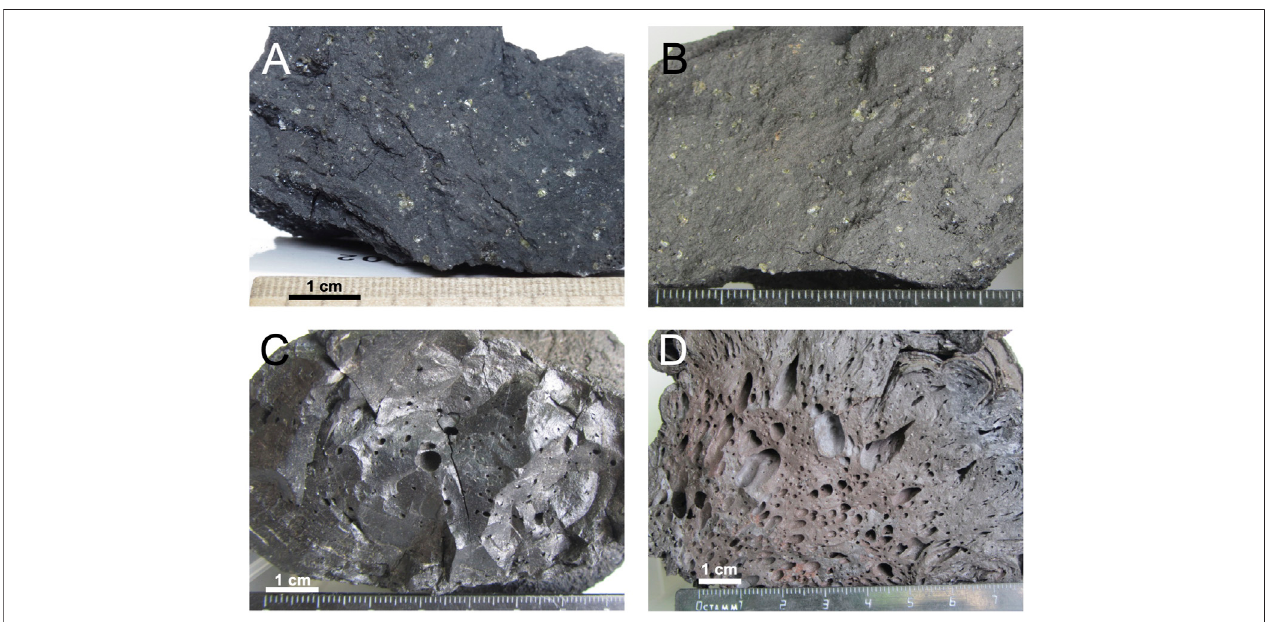
FIGURE 2 | Olivine-phyric high-Mg basalts of Cone Mt. 1004 (A, B) and plagioclase-phyric low-Mg basalts of the 2012 – 2013 eruption (C, D) .